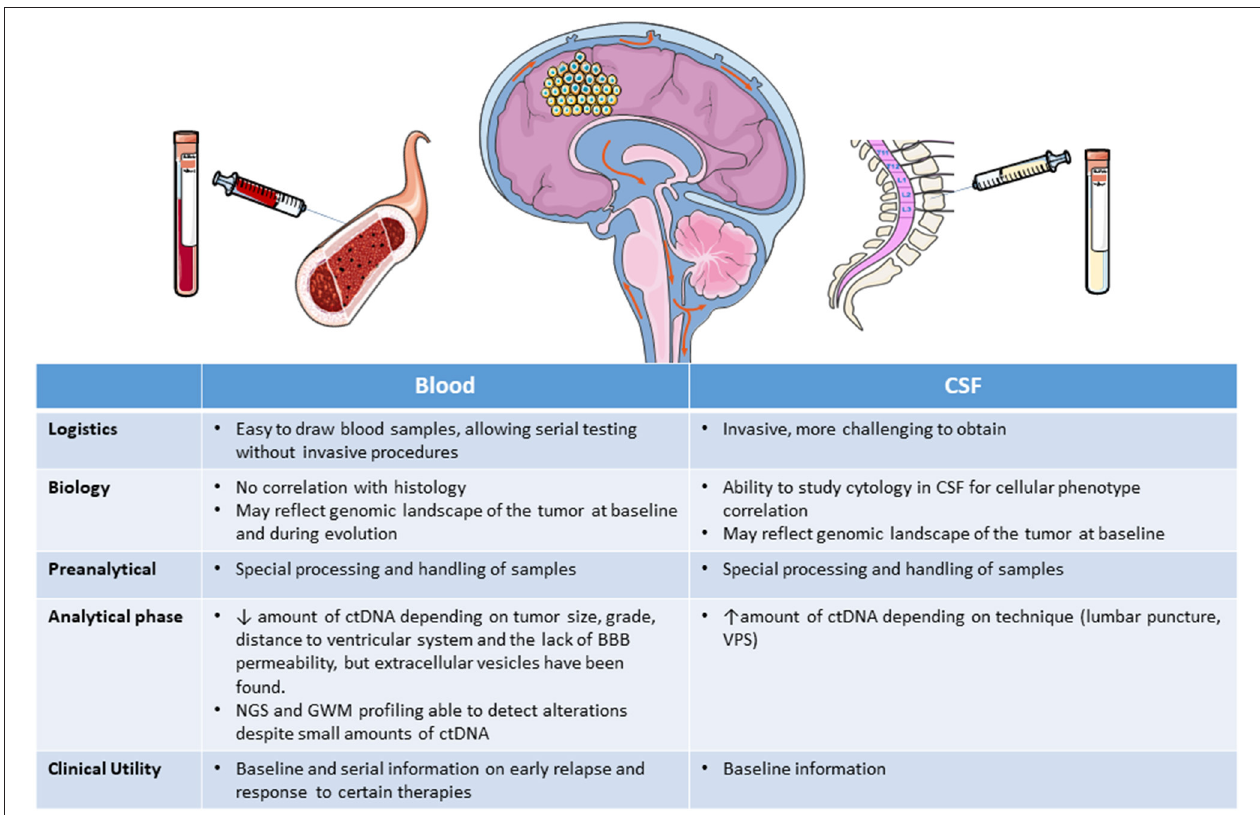
FIGURE 2 | Liquid biopsy obtained from blood or CSF. BBB, brain-blood barrier; CSF, cerebrospinal fluid; ctDNA, circulating tumor DNA; GWM, genome wide methylation; NGS, next generation sequencing; VPS, ventricular-peritoneal